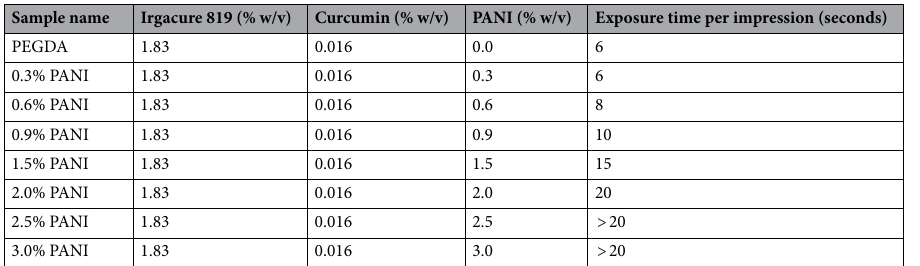
Table 1. Experimental parameters for preparing and printing conductive